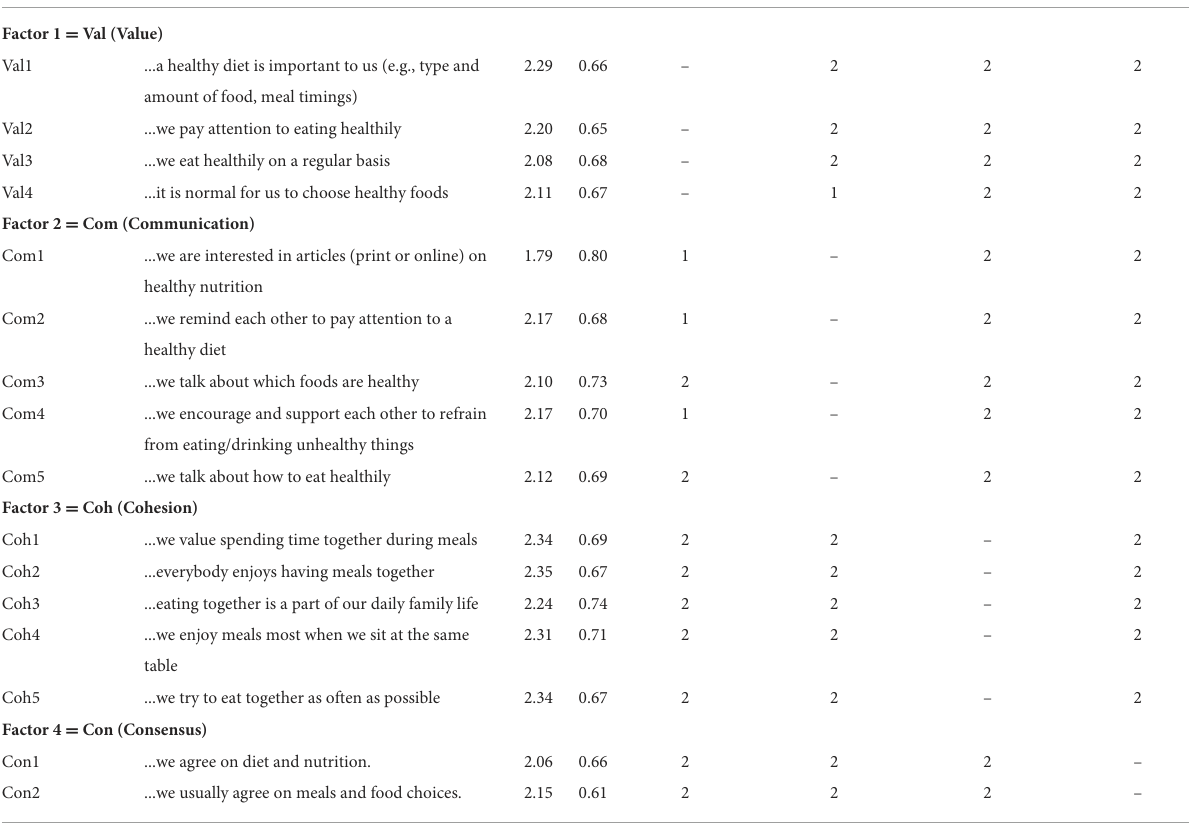
TABLE 7 Item-level discriminant validity testing for FHC-NU (Sg). FHC-NU (Sg) Label Item Description (In our family...)